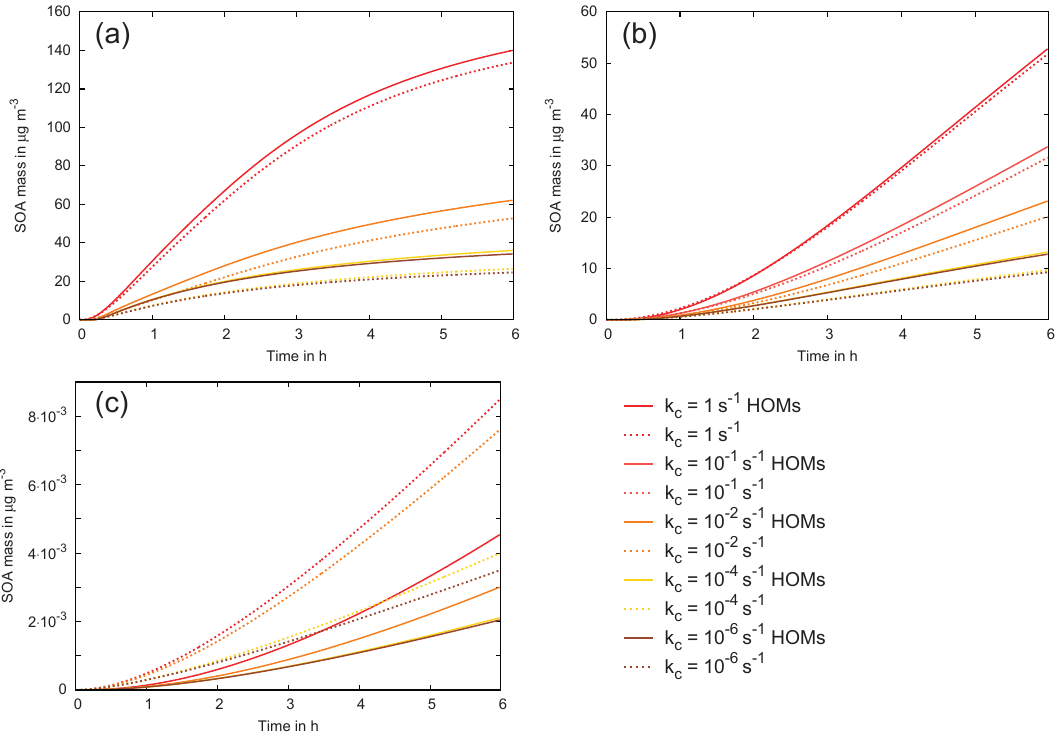
Figure 4. Simulated SOA mass including HOMs and additional variation of the pseudo-first-order rate constant of particle reactions k c (cases 6a and 6b of Table 1) for (a) liquid ( D b = 10 − 12 m 2 s − 1 ), (b) transition between liquid and semi-solid ( D b = 10 − 14 m 2 s − 1 ), as well as (c) semi-solid ( D b = 10 − 18 m 2 s − 1 ) aerosol particles.